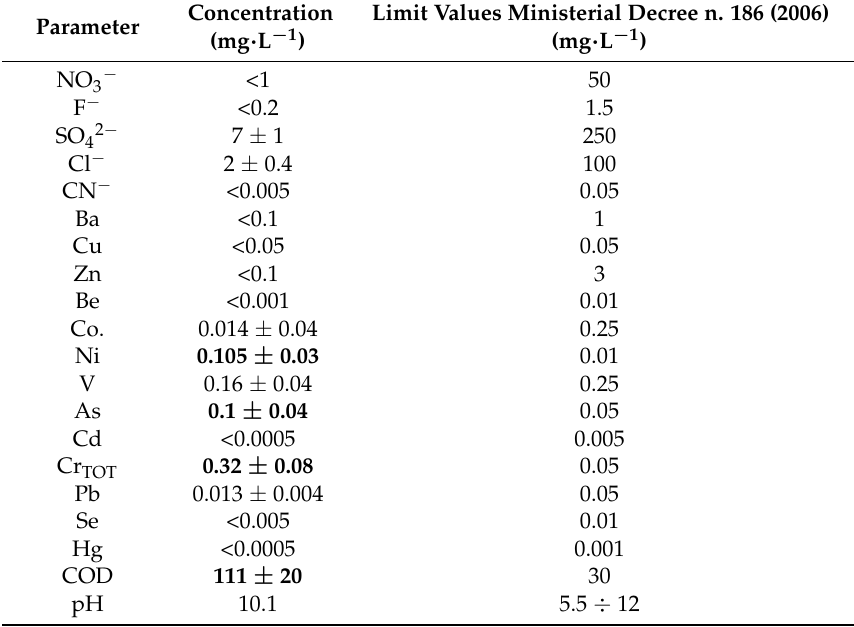
Table 4. Results of leaching test (UNI EN 12457-2) on solid residue from WO (soil #1—T: 300 ◦ C, reaction time: 30 min, initial pO 2 : 1520